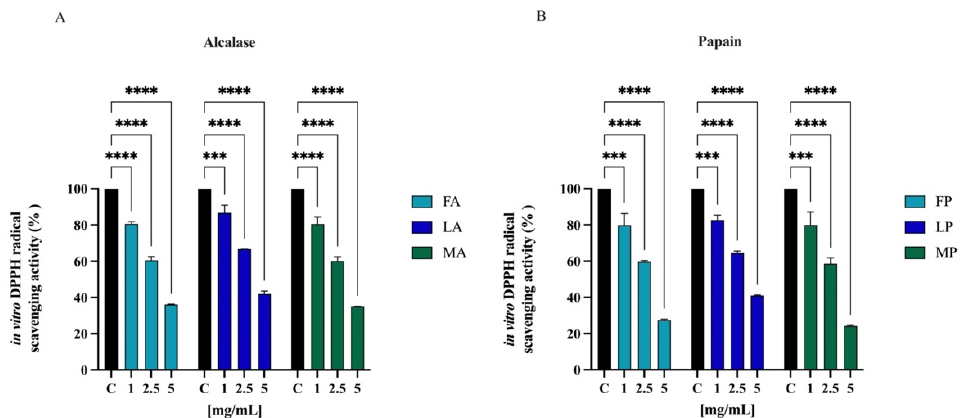
Figure 6. Direct radical scavenging activity of olive seed hydrolysates rom Frantoio (F), Leccino (L), and Moraiolo (M) obtained using alcalase (A) ( A ) and papain (P) ( B ) by DPPH assay. Data represent the mean ± s.d. of six independent experiments, and each experiment was performed in triplicate. All the data sets have been analyzed by two-way ANOVA. (****) p < 0.0001, (***) p < 0.001.